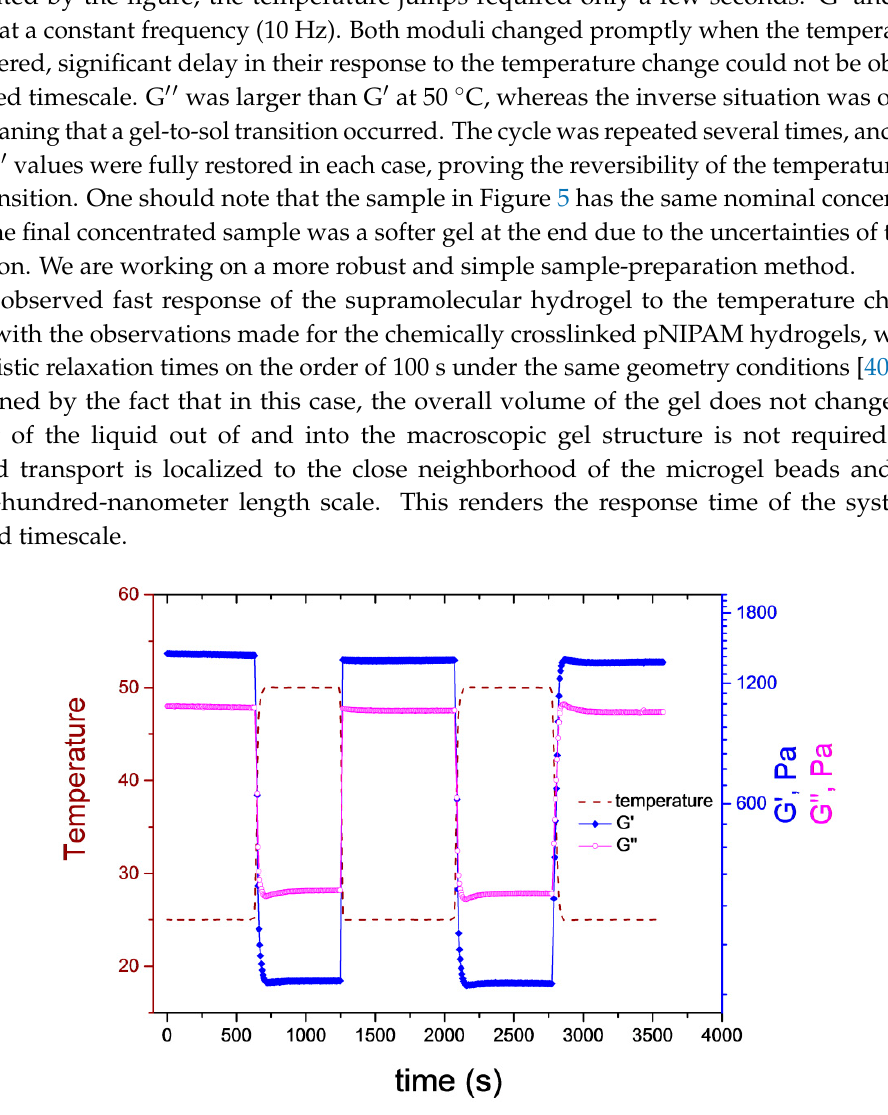
Figure 5. Oscillatory rheological measurements of G3 under temperature ramps ( f = 10 Hz, γ = 0.1%).